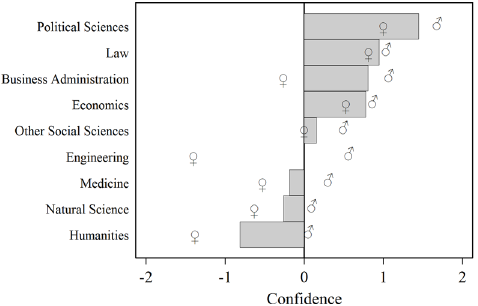
Fig 1. Mean confidence levels by field of study and gender. Bars show mean confidence for both genders. The symbols ♂ and ♀ indicate mean confidence of male and female subjects, respectively. Political Science, Law, Business Administration and Economic students exhibit the highest confidence levels, whereas Humanities, Natural Science, Medicine and Engineering fall at the other end of the scale. To a large extent ordering of disciplines remains the same when looking at each gender separately. Females generally exhibit lower confidence levels.